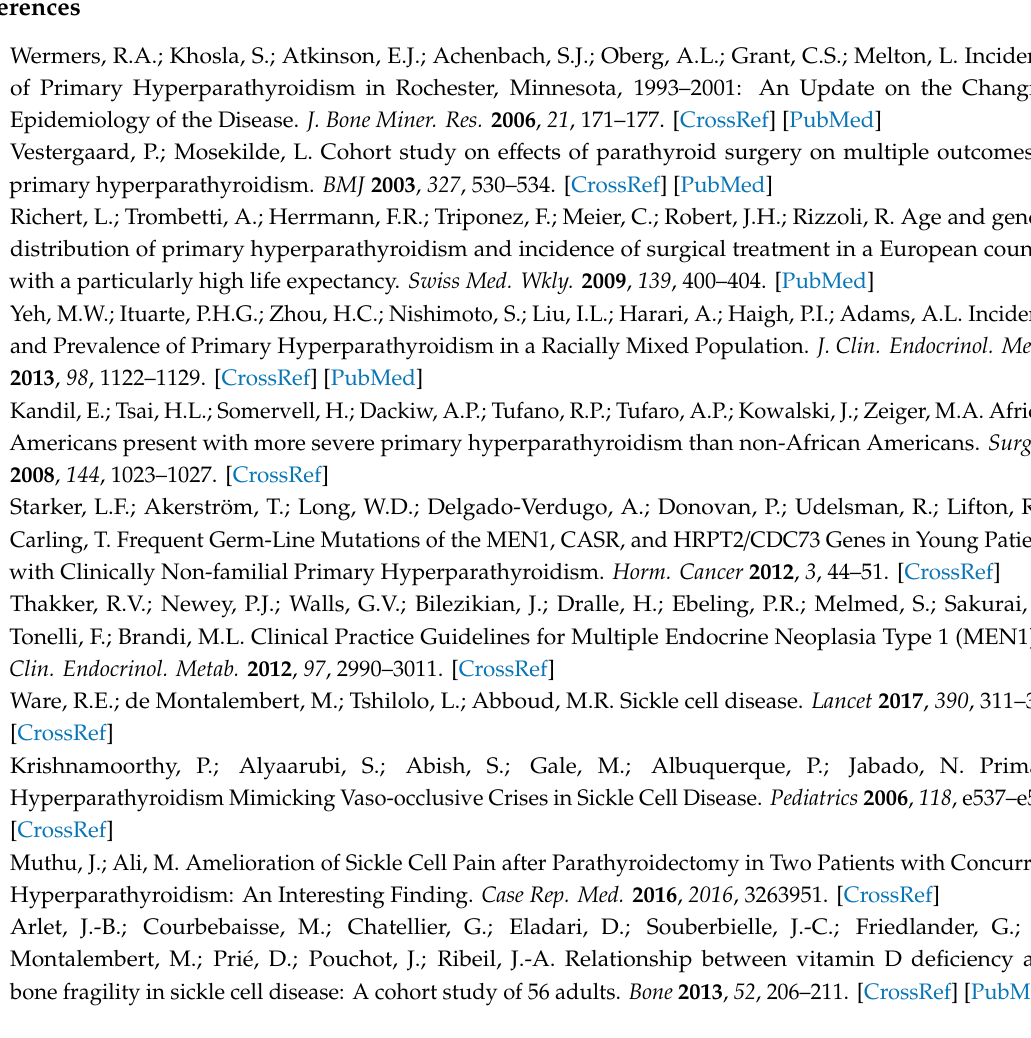
Table S1: Laboratory normal value ranges in each